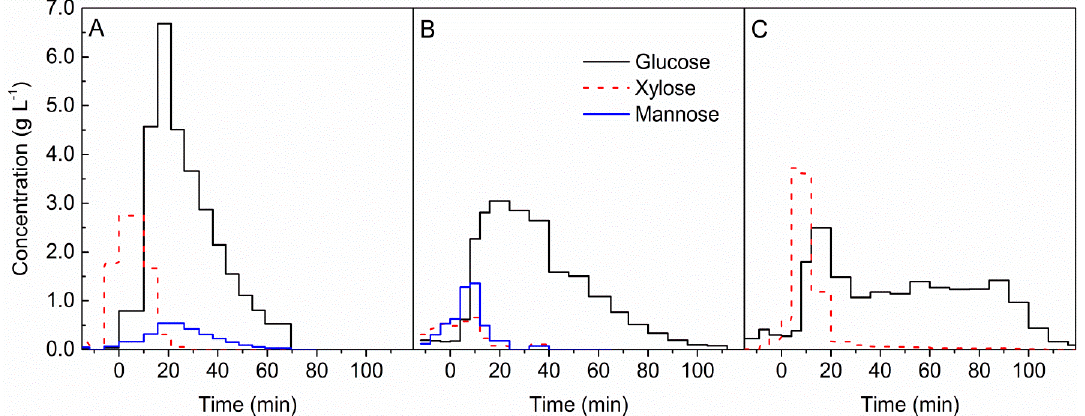
Figure 3. Formation of sugars during the hydrolysis of ( A ) beech wood, ( B ) spruce wood, and ( C ) Miscanthus x giganteus with 0.05 mol L − 1 sulphuric acid at a temperature of 200 °C. t = 0 min marks the beginning of acid hydrolysis.